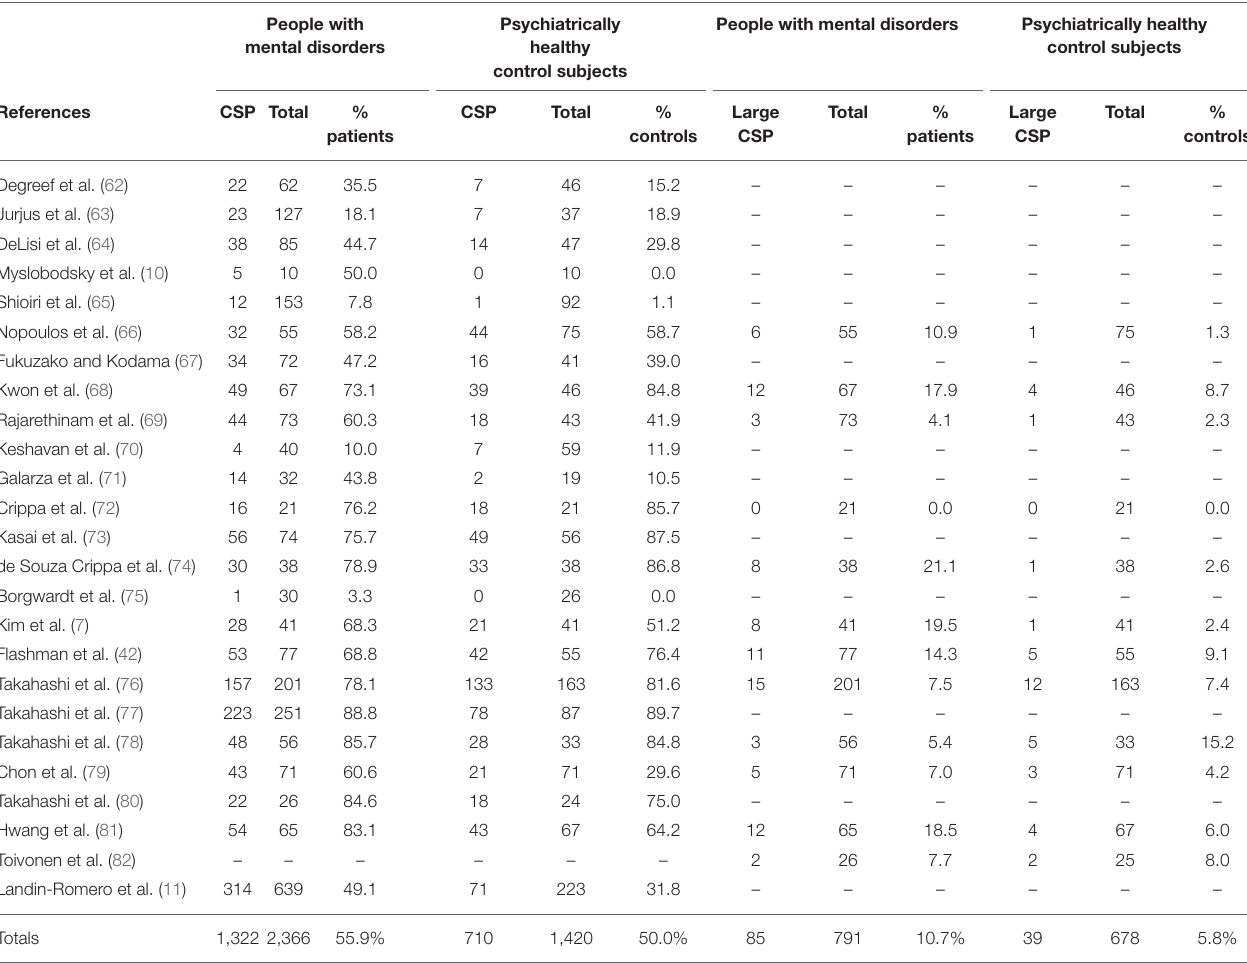
TABLE 4 | CSP in people with mental disorder and healthy control subjects, visible on MRI. People with mental